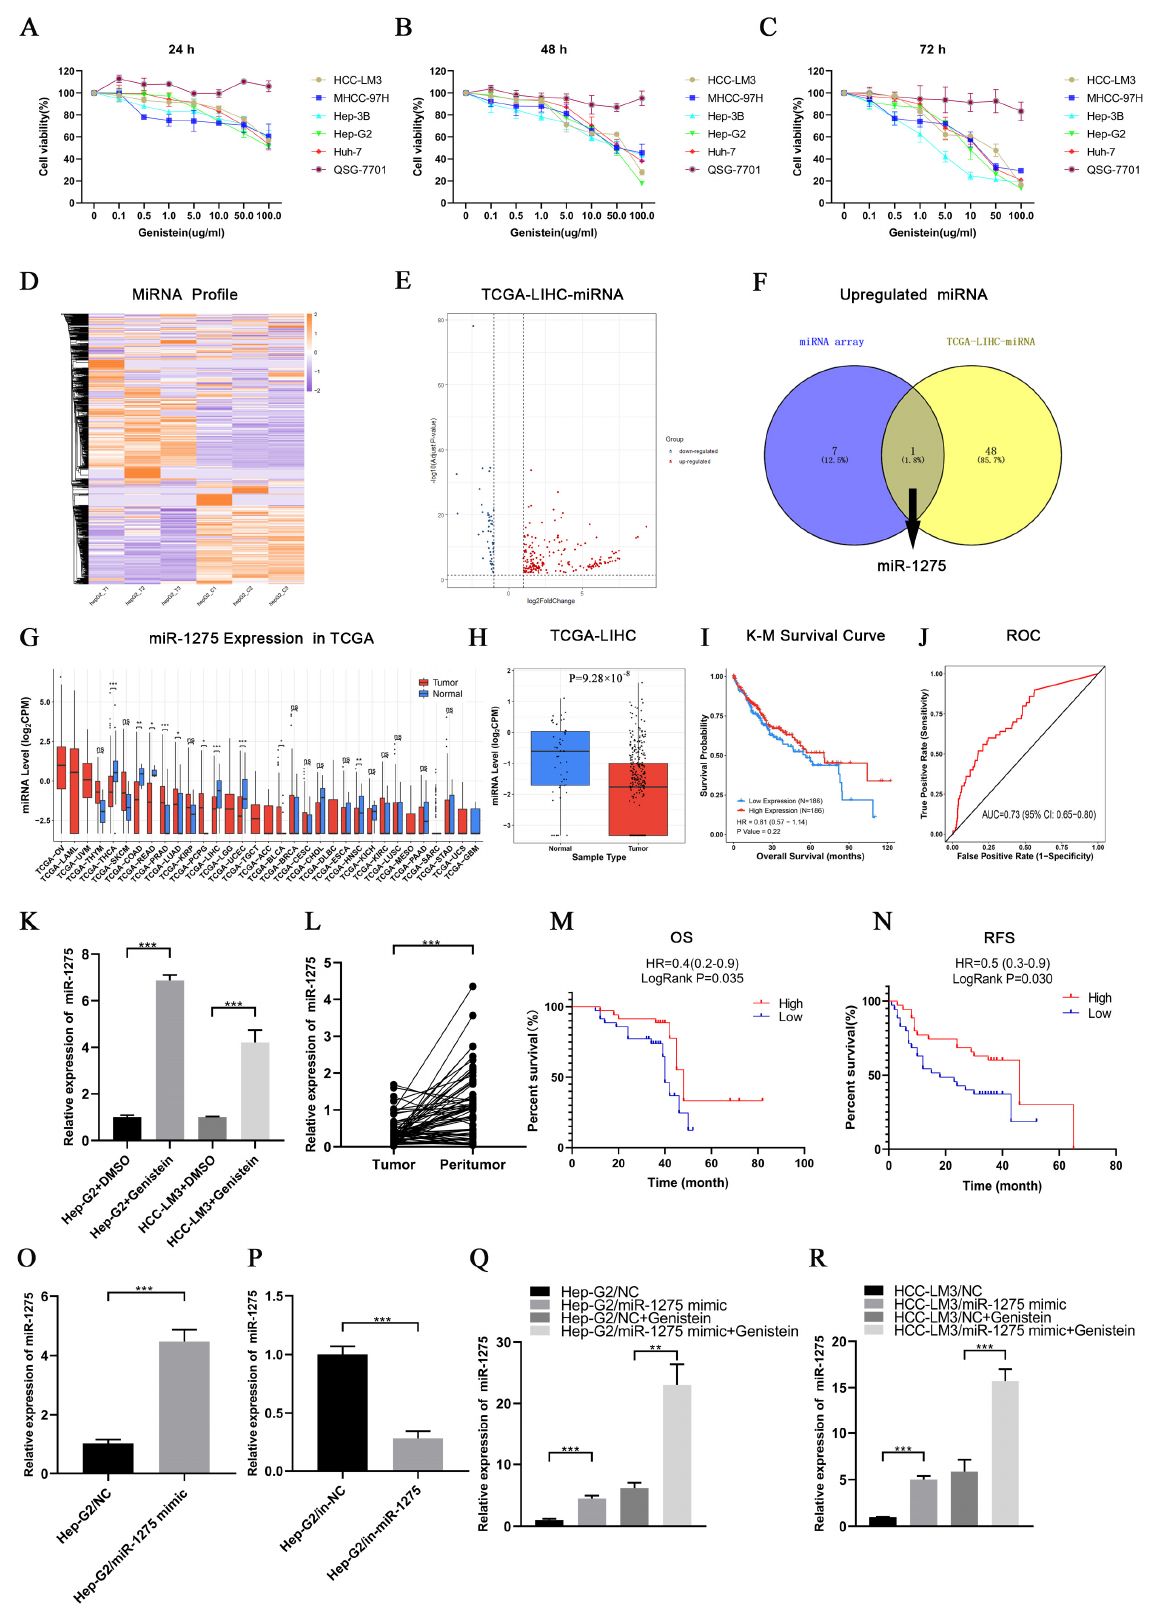
Figure 1. Genistein inhibited the viability of HCC cells and upregulated miR-1275 in HCC cells. ( A – C ) Cell viability of five HCC cell lines (HCC-LM3, MHCC-97H, Hep-3B, Hep-G2, Huh-7) and normal hepatocytes (QSG7701) treated with genistein (0, 0.1, 0.5, 1.0, 5.0, 10.0, 50.0 and 100.0 µg/mL)